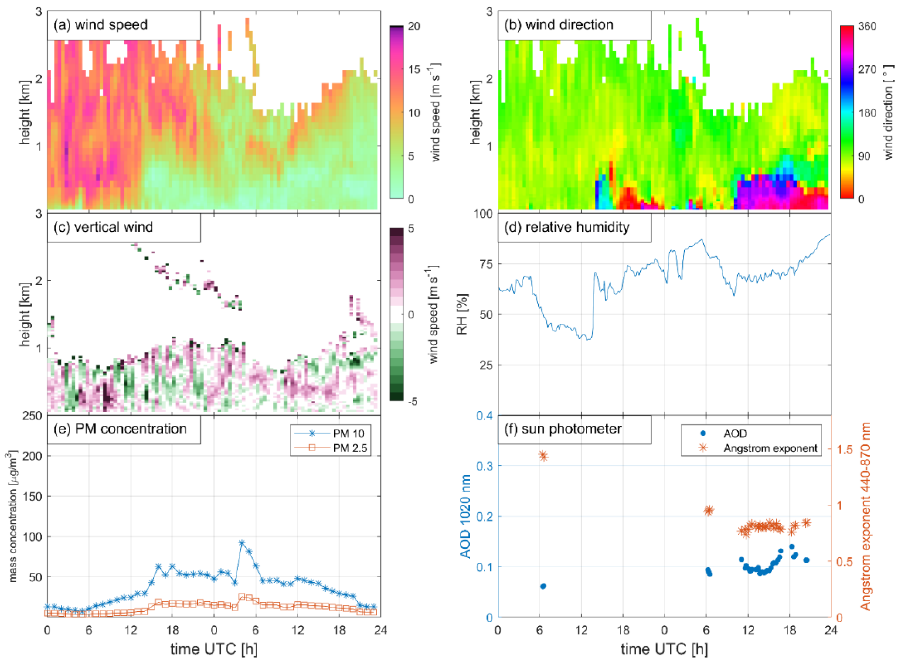
Figure 11. Wind speed ( a , [m s − 1 ]), wind direction ( b , [°]), vertical wind velocity ( c , [m s − 1 ]), relative humidity ( d , [%]), PM 10 ( e , blue) and PM 2.5 ( e , orange) concentration ([ μ m m –3 ]), and sun-photometer observations ( e ) on 31 July and 1 August, 2019, at RVK. The wind velocities are retrieved from lidar VAD scan. PM concentrations are measured at Njorvasund, Reykjavik. The relative humidity is measured at the weather station at IMO headquarters. The blue dots in ( f ) are AOD at 1020 nm, and the orange asterisk markers are Angstrom exponent (440–870 nm). The time axis starts from 00:00 UTC, 31 July, 2019.